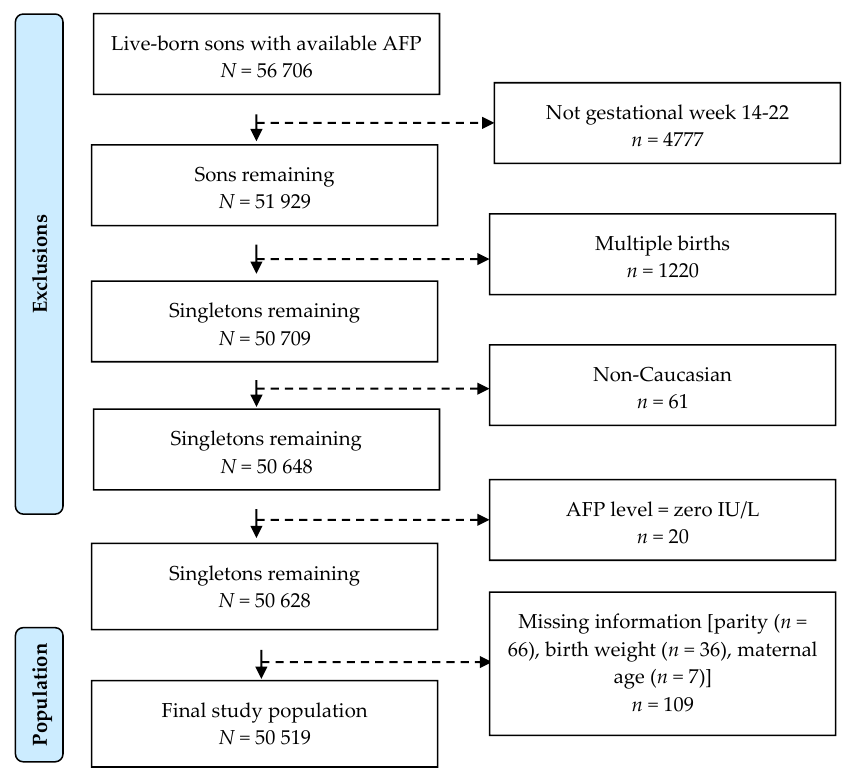
Figure 1. Flowchart of the study population.